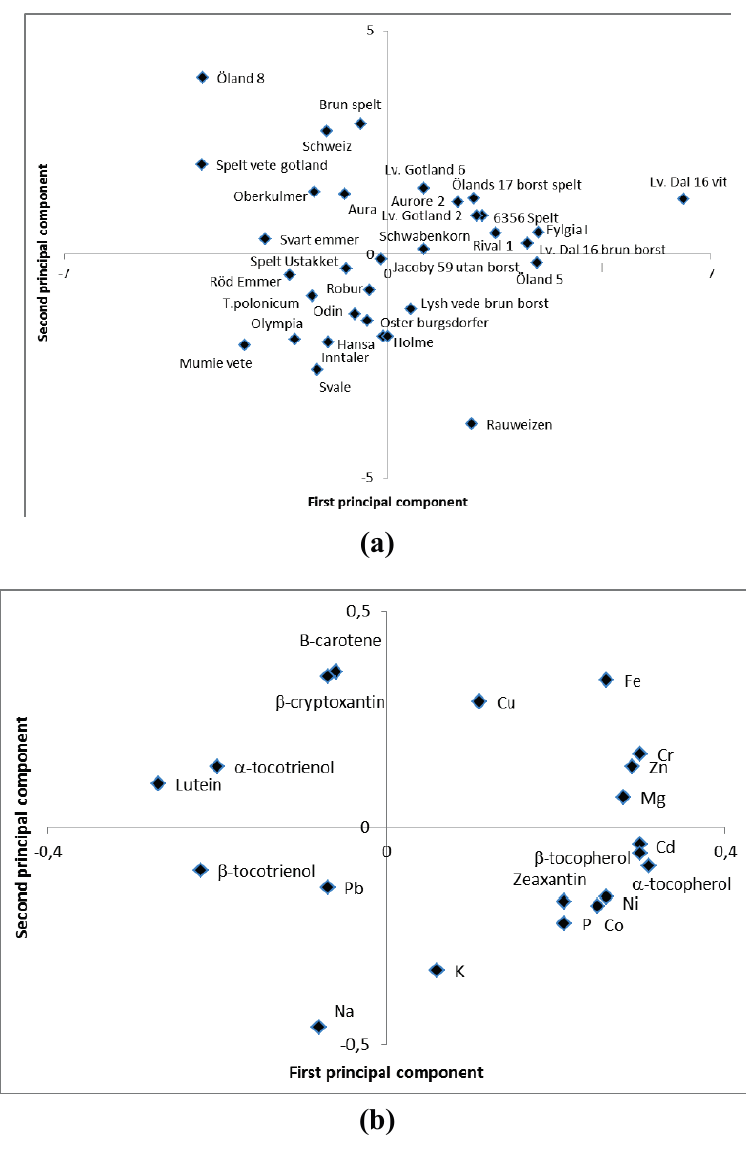
Figure 2. Loading ( a ) and score ( b ) plot from principal component analysis of compounds (carotenoids, tocopherols, minerals and heavy metals) in wheat of a diverse